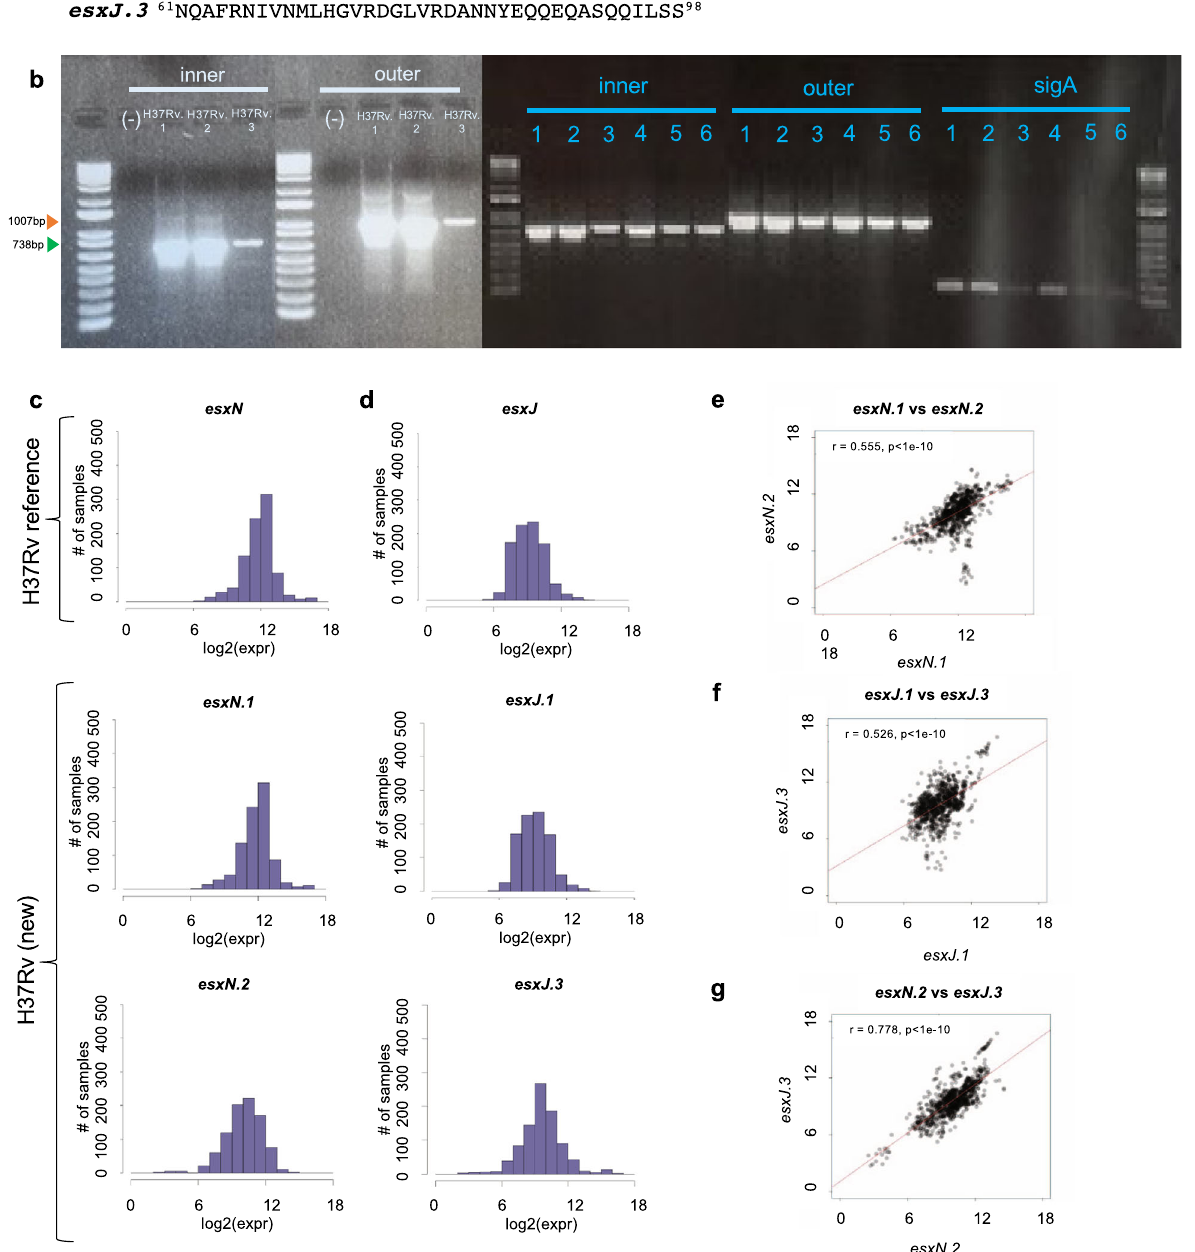
Fig. 3| Identifying R3inallH37Rvstrains.a ClustalOmegacomparison of amino acidsequencefor esxN and esxN.2 andbetween esxJ,esxM and esxJ.3 . b .PCRofR3in all 3 laboratory replicates of H37Rv (H37Rv.1-3), H37Rv1998 (1-3) and 3 commer- cially available strains of H37Rv from ATCC (4: NR-123, 5: TMC102, 6: TMC301). Inner primers targeted inside the region (738bp) and outer primers targeted fl anking regions (1007bp). SigA primers were used as a housekeeping control. c-d